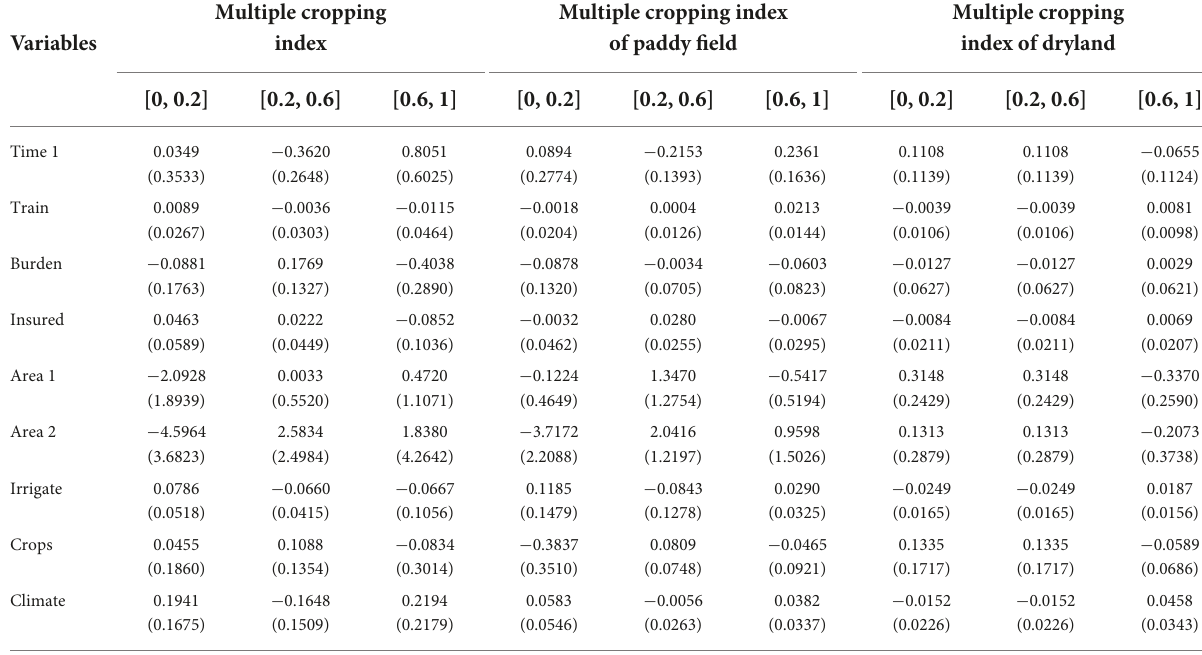
TABLE 5 Generalized propensity score matching estimation and balance test results.